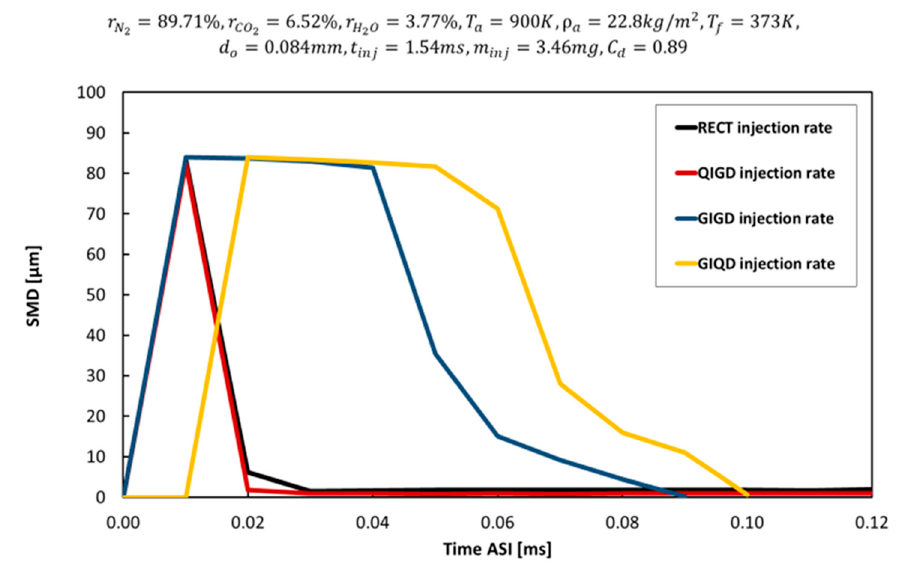
Figure 17. Comparison of the Sauter mean diameter (SMD) for different injection rate shapes.